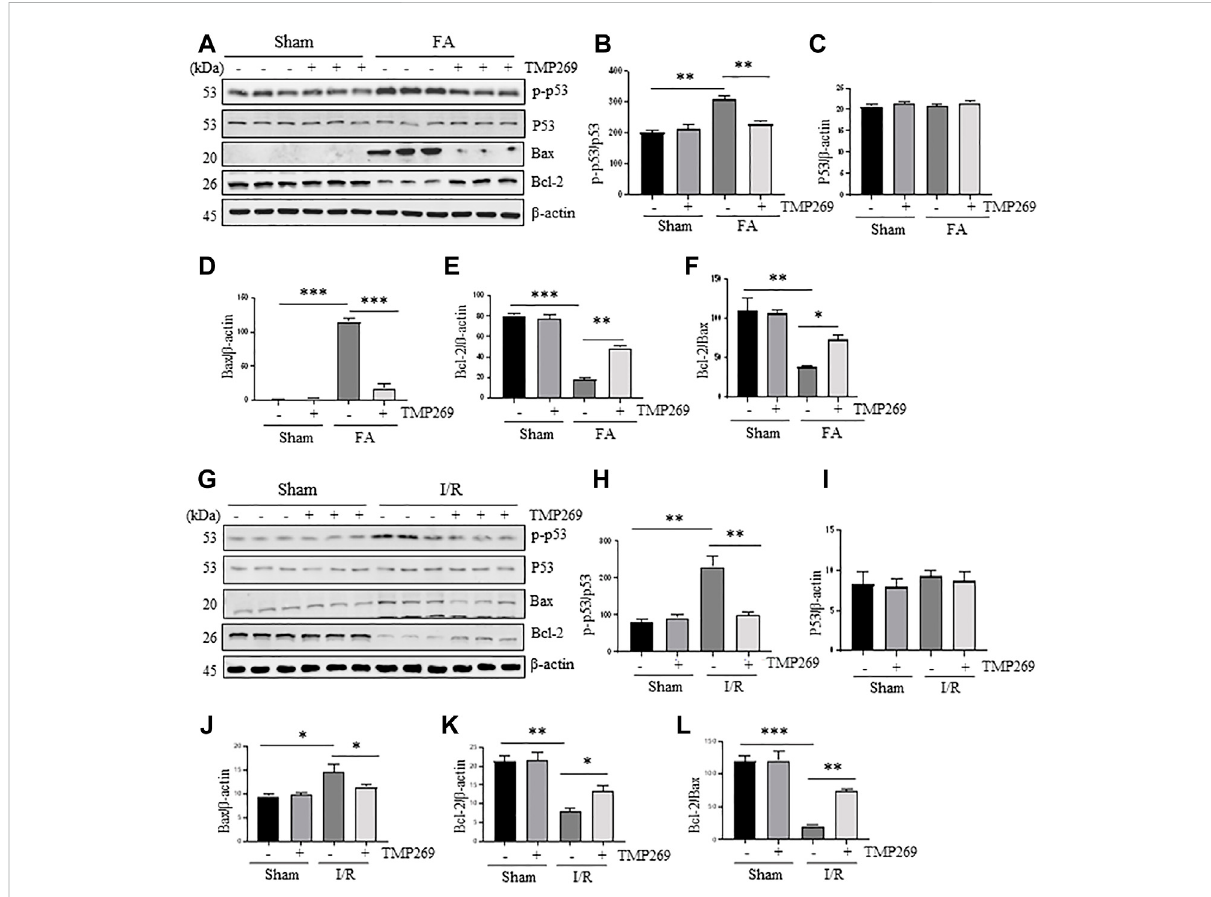
FIGURE 4 Administration of TMP269 regulates the expression and activation of apoptosis-related signal molecules in the kidney following FA and I/R injury (A,G) Kidneys were injured by FA or IR, respectively, and tissue lysates were subjected to immunoblot analysis with speci fi c antibodies against phospho-p53 (p-p53), p53, Bax, Bcl-2 or β -actin. Representative immunoblots are three samples in each group (B,H) Expression levels of phospho- p53 (p-p53) were quanti fi ed by densitometry and normalized with p53 (C – E, I – K) Expression levels of p53, Bax or Bcl-2 were quanti fi ed by densitometry, respectively and normalized with b-actin, respectively (F,L) The ratio of Bcl-2/Bax were calculated. Data are means ± SD ( n = 3). * < 0.05; ** p < 0.01; *** p <